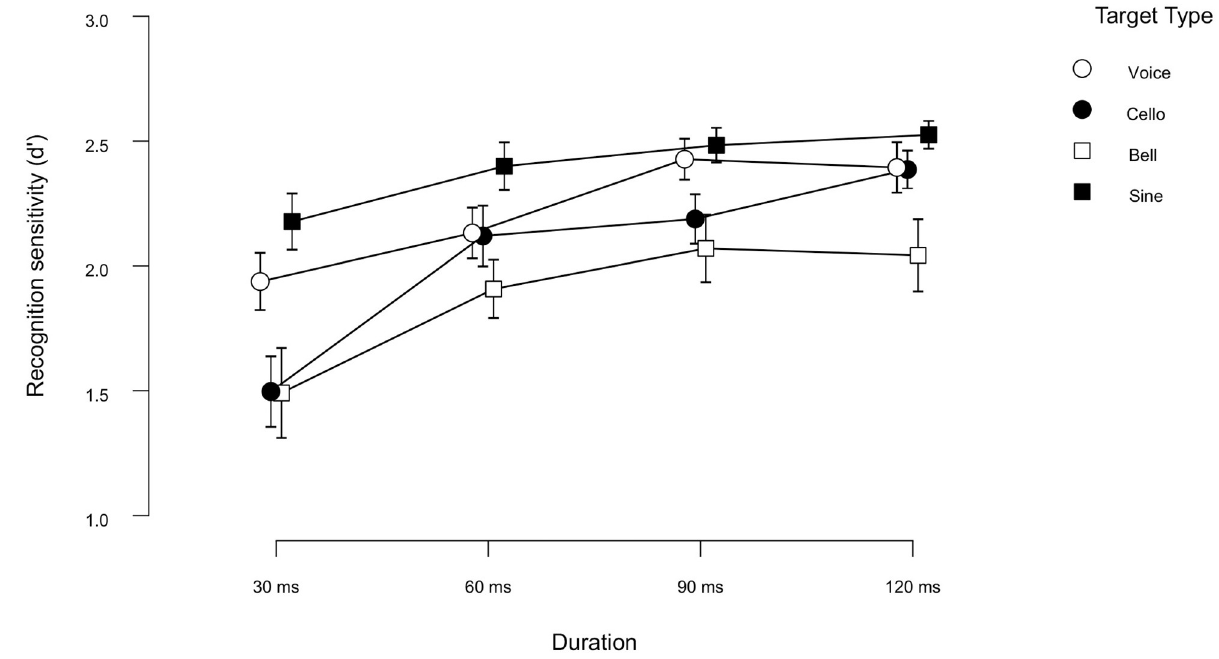
Fig 4. Target recognition sensitivity ( d ’) plotted as a function of stimulus duration condition (for Exp1b). Open circles, closed circles, open squares, and closed squares represent the data when the target was selected from voice, cello, bell, and sine tone categories, respectively. Error bars represent standard error of the